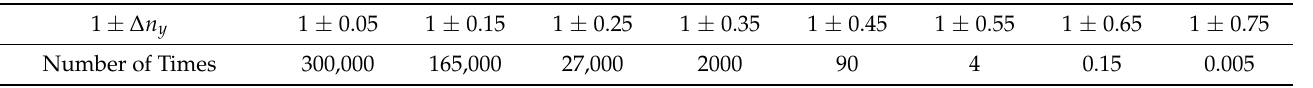
Table 5. Number of times per thousand runway landings that dynamic load factor (1 ± ∆ n y ) is experienced [20]. 1 ± ∆ n